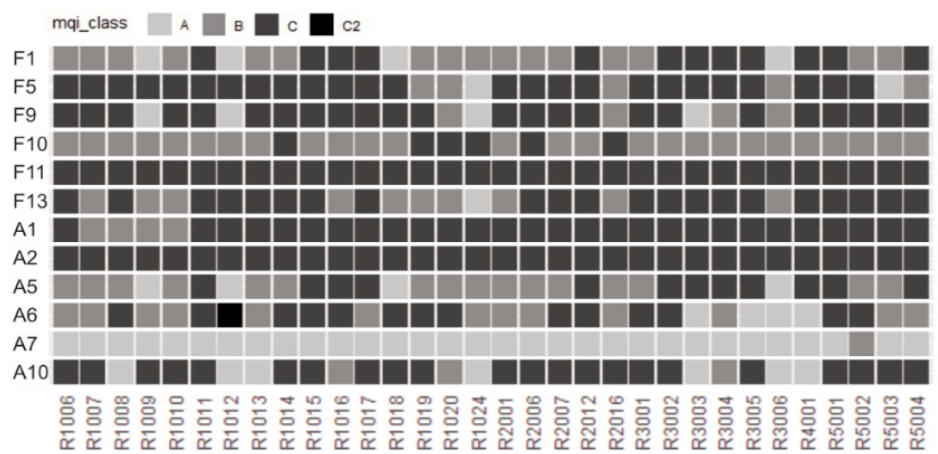
Figure 4. Evaluation of the Nanxi river basin: classification of 32 reaches in five streams concerning